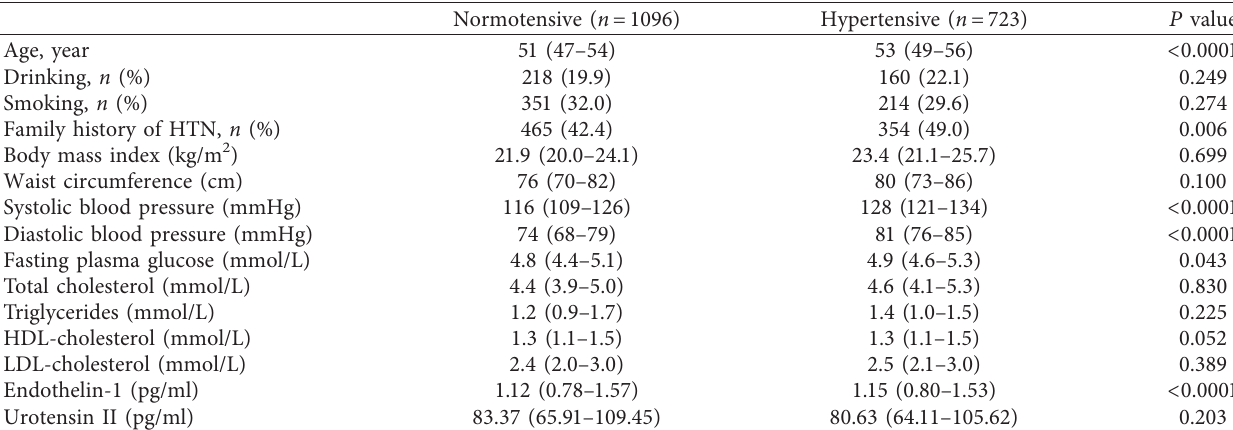
Table 2: Comparison of baseline characteristics between the new cases of hypertension and the normotensive participants.